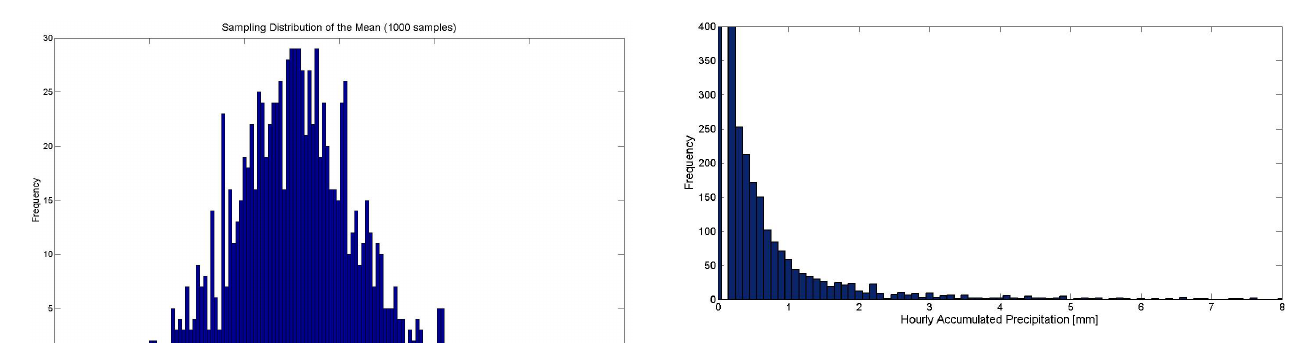
Fig. 6. Distribution of hourly accumulated precipitation at the Boul- der, Colorado, USCRN site over 2009–2010. For visual purposes, the domain and range of this figure do not encompass all of the data. The true peak in the distribution actually has a frequency of over 15000 for the zero precipitation event (0mm accumulation), and there are some isolated events where more than 8mm of pre- cipitation accumulates in an hour.